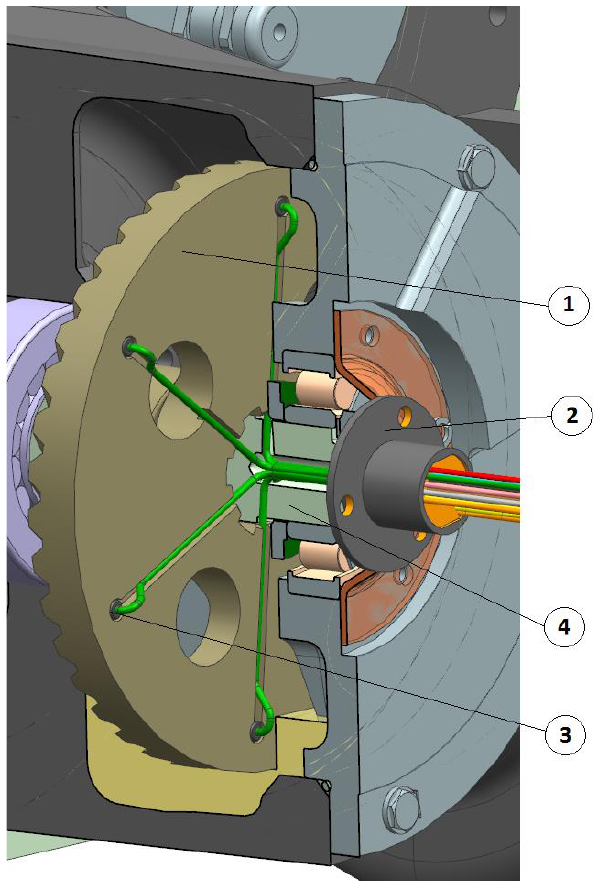
Figure 9. Location of thermocouples on the face gear; 1 — face gear, 2 — rotating joint, 3 — temperature sensor, and 4 — face gear shaft. The electric wires of the thermocouples were led outside the gear casing through a hole made on the shaft on which the face gear is mounted. The entire measuring unit is closed by joint located on the front side of the shaft.